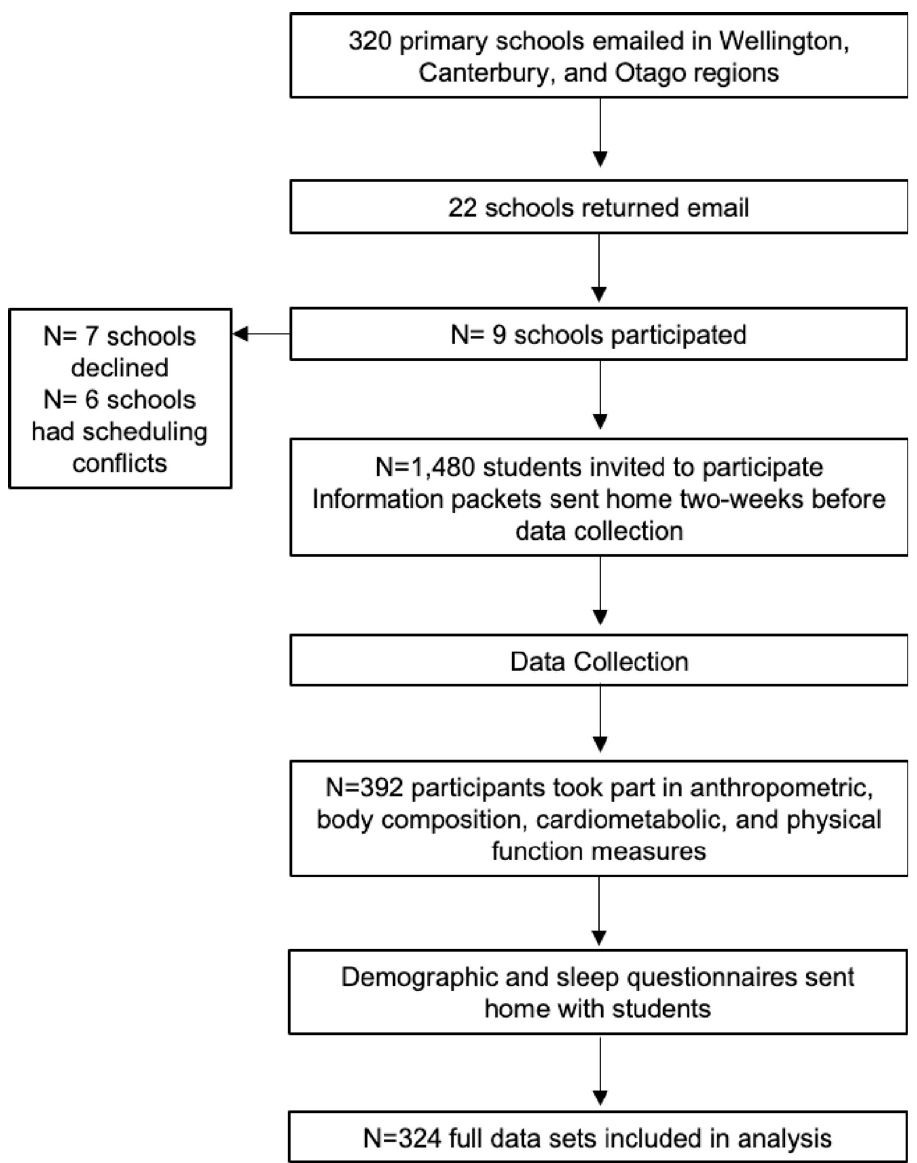
Fig 1. Study design and protocol. Includes information regarding recruitment, data collection, and analysis